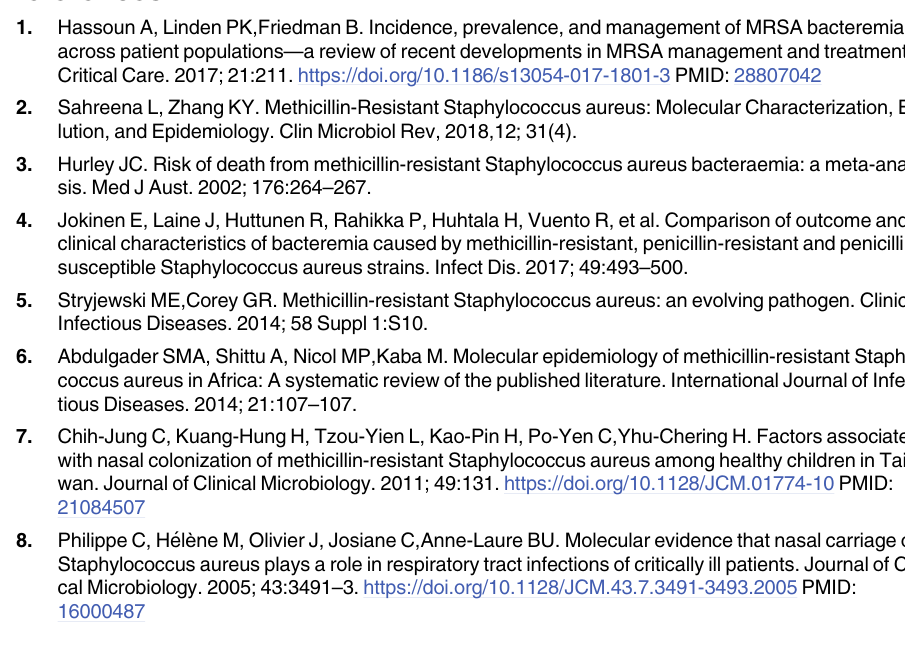
S1 Table. PRISMA checklist. S2 Table. Quality assessment of the included